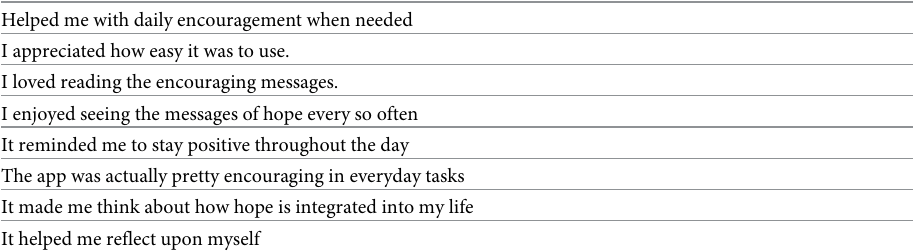
Table 4. Participants’ comments about the